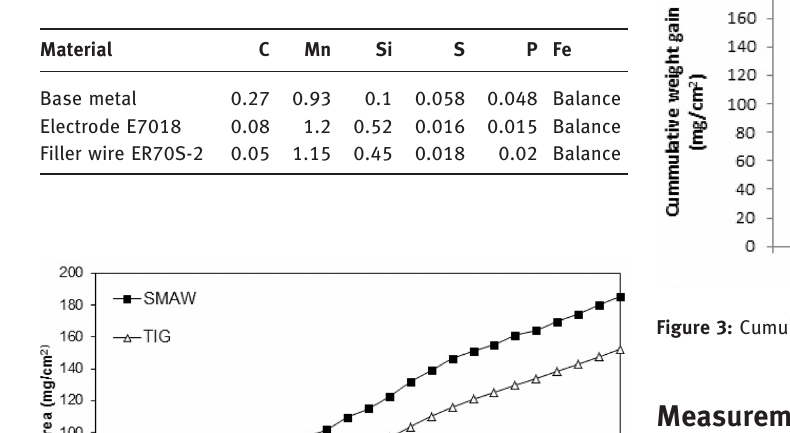
Table 2: Chemical composition (wt %) for Gr A1 boiler tube steel and electrode/filler wire used in present study.